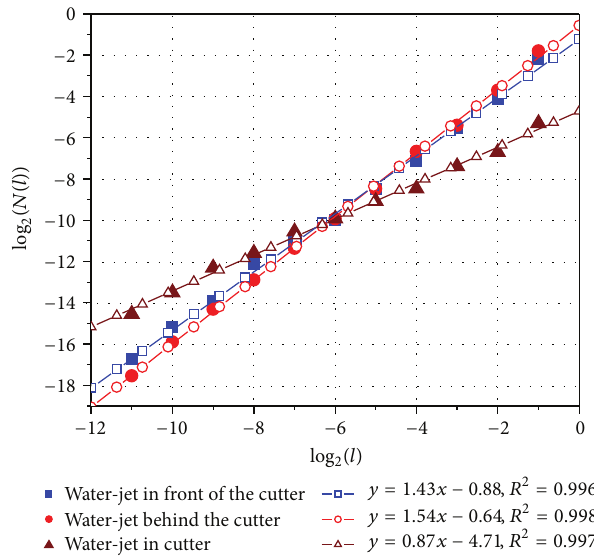
Figure 10: Box-counting dimension of cutting load under assisted water-jet